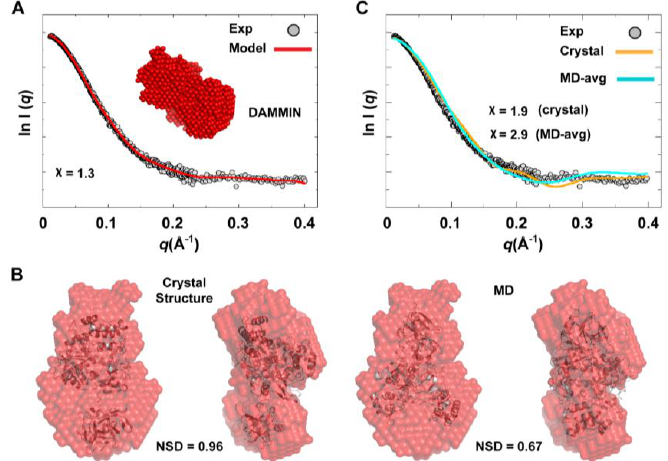
Figure 10. Ab initio SAXS model and fitting of single-conformation to experimental scattering data. ( A ) Shown are the average SAXS model constructed using DAMMIN (red spheres) and the fitting of the reference model (red line) to experimental SAXS data (grey). ( B ) The crystal and average MD structures of 3CD, represented as cartoons, are fitted to the DAMMIN model that is shown in A (red transparent surface); two different views are displayed for each fitting. The average MD structure fits the SAXS model slightly better (NSD = 0.67) than the crystal structure (NSD = 0.96). In both cases, however, the exact orientation of the structures cannot be determined without ambiguity; ( C ) The calculated scattering profiles of the crystal and average MD structures are compared to experimental data. The agreement between theoretical profiles and experimental data is relatively poor as indicated by the χ-values, suggesting that no single conformation can satisfactorily fit the experimental data. To assess the possibility of the presence of multiple conformations for 3CD in solution, we employed the Ensemble Optimization Method (EOM). This method assumes that a mixture of different conformers co-exist in solution and finds the best sub-ensemble out of a randomly generated ensemble consisting of a large number of conformers that best fits the experimental data. From an ensemble of 3CD conformers in which the 3C-domain and the linker residues were allowed to adopt